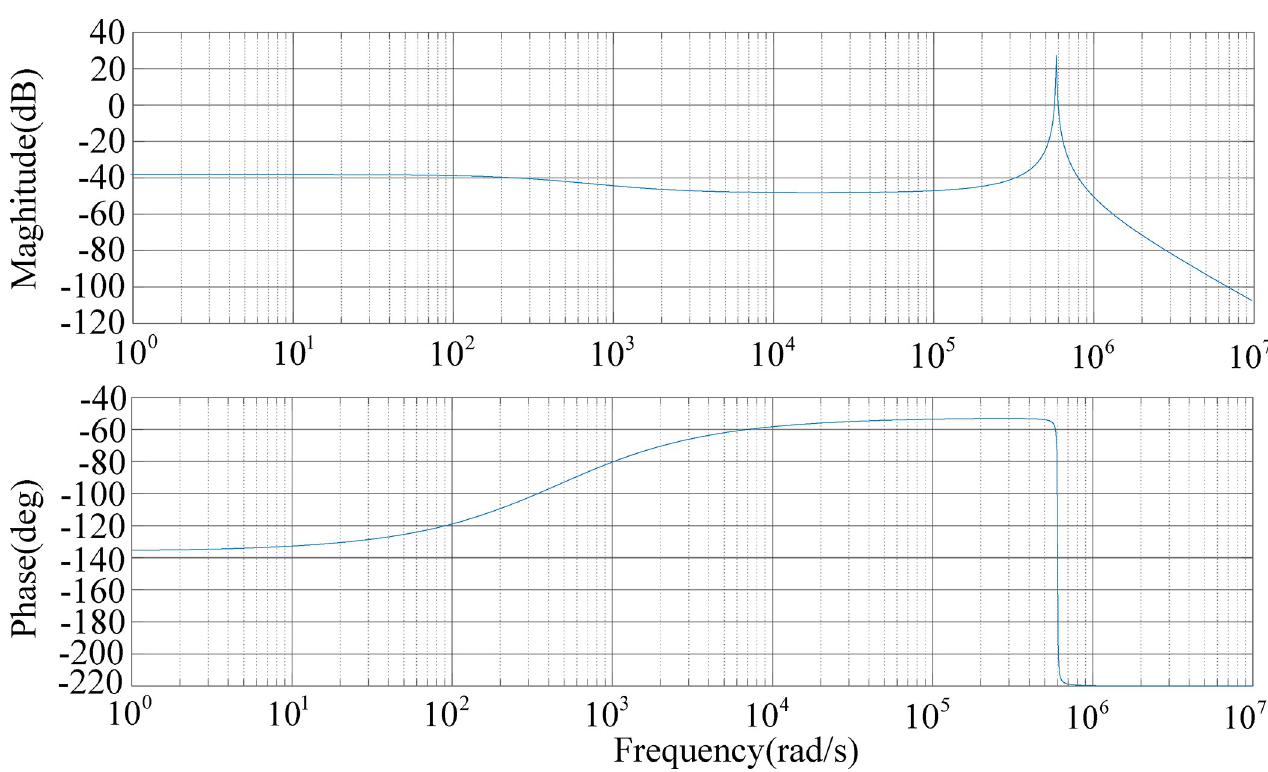
Fig 12. Bode plot of system transfer function without the PI controller.